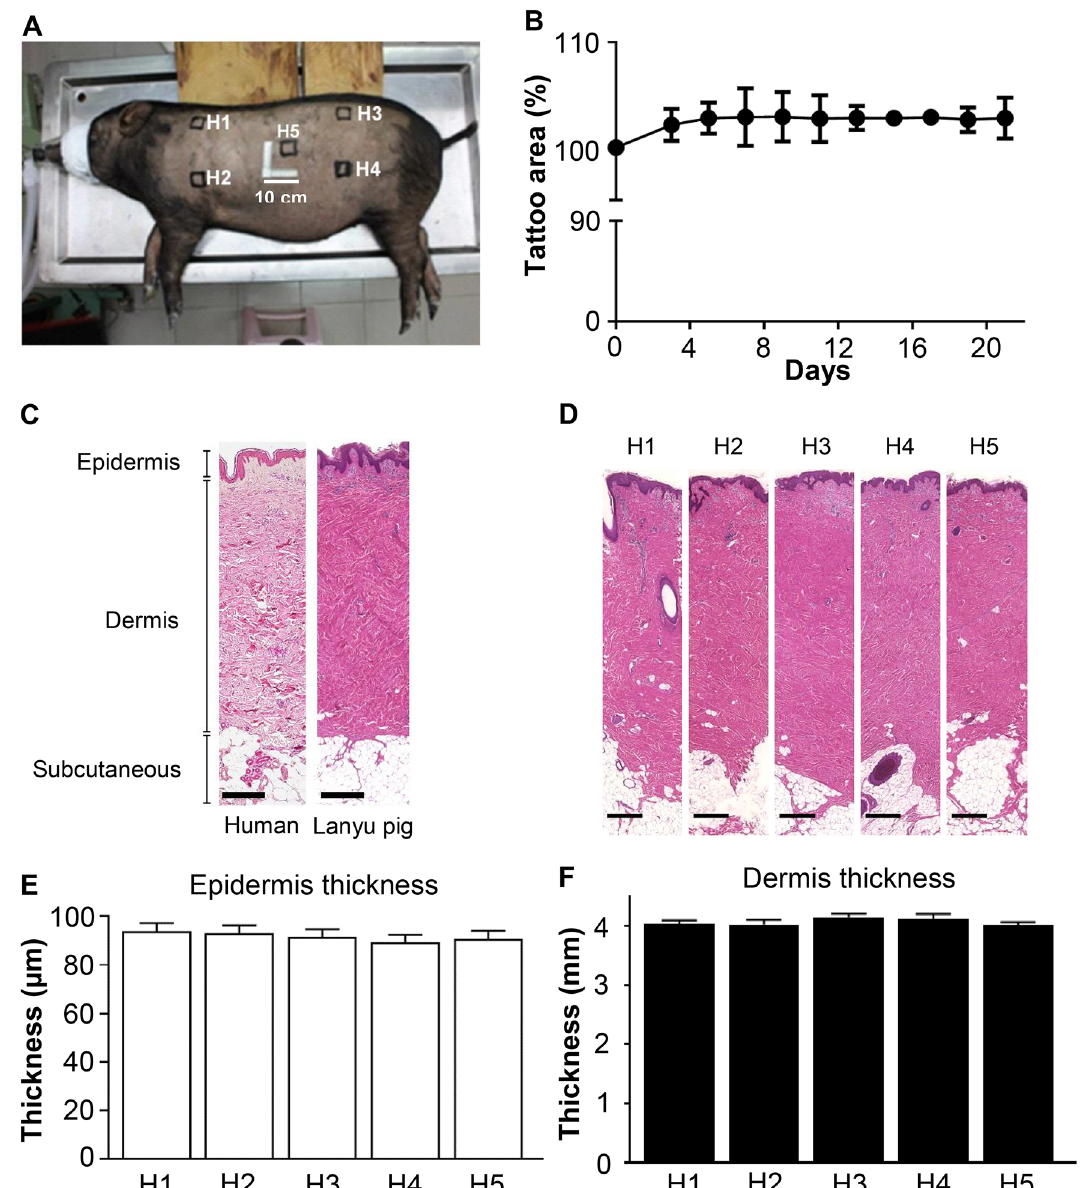
Figure 2. Variations in structure and histology at different regions of dorsal skin were compared on a Lanyu pig. ( A ) Square tattoos sized 2.5 cm × 2.5 cm were made on the dorsal skin of two Lanyu pigs. Five tattoos were indicated as H1, H2, H3, H4, and H5 (bar = 10 cm). ( B ) The size changes in each tattoo area were monitored for 22 days ( n = 5). ( C ) Histological comparison of human skin and Lanyu pig skin (bar = 500 µm). ( D ) Histological comparison of skin at the five regions as indicated in ( A ) (bar = 500 µm). ( E ) The epidermal thicknesses of five tattoos were measured; data values are presented as mean ± standard deviation (SD). ( F ) The dermal thicknesses of the five tattoos were measured; data values are presented as mean ± SD. No significant differences in epidermal and dermal thickness were observed among tattoo groups using ANOVA statistical Requirement of ≥ 4 cm interval distance between adjacent wounds to prevent interference during wound healing. The optimal distance between wounds is critical for the wound array model. The wound healing profiles of adjacent wounds, separated by 1, 2, 3, 4, 5, and 6 cm, were monitored over time. The red lines in Fig. 4A define the blood flow signals observed in a 1 cm-thick area from the midline of the inter- wounds beyond the wound edge in four directions. Results are presented as the region of interests (ROI) per unit area at different time points after wounding when compared with ROI per unit area of the respective original skin. The blood flow signals in Fig. 4B reveal that the signal beyond the wound edge was the most outgrown on day 5 after wounding, which regressed on day 7, regardless of the wound distance. On day 5, blood flow signals with a 4 cm distance barely touched each other; therefore, a ≥ 4 cm interval distance between adjacent wounds was required to prevent significant interference during wound healing. In Fig. 4D, blood flow signals